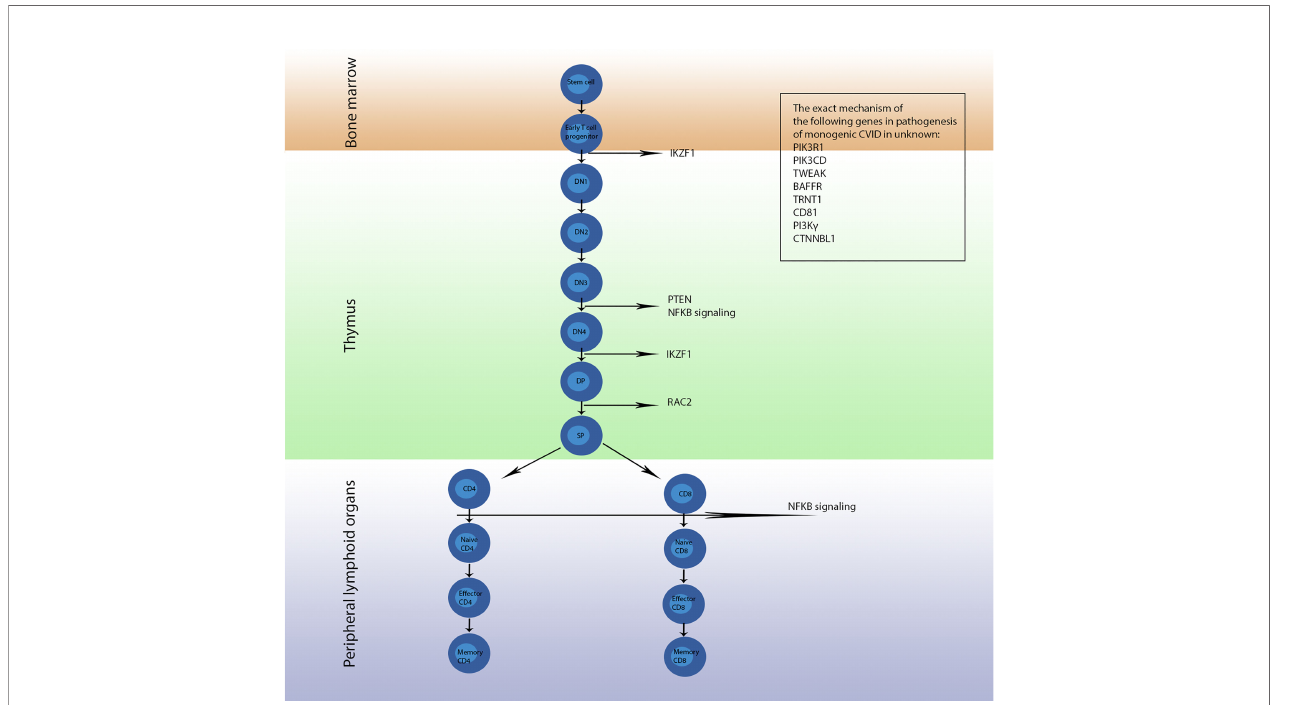
FIGURE 2 | The development pathway of T cells and genes involved in each stage; mutation of these genes leads to monogenic CVID. Conversion of early T cell progenitor to double negative 1 (DN1) cells is regulated by the protein encoded by IKAROS, a transcription factor encoded by the IKZF1 gene, which later is involved in conversion of stage double negative 4 (DN4) to stage double positive (DP). PTEN , NFKB1 and NFKB2 encode proteins involved in development of stage DN3 to stage DN4. Then, RAC2 regulates differentiation of DP cells to single positive (SP) cells. Furthermore, NF- k B1 and NF- k B2 regulate the conversion of CD4 + cells to na ϊ ve CD4 + cells as well as CD8 + cells to na ϊ ve CD8 + cells. The exact mechanism and location of action of proteins encoded by the PIK3R1 , PIK3CD , TWEAK , BAFFR , TRNT1 , CD81 , PI3K g and CTNNBL1 genes are not understood and further studies are required to come to a de fi nite